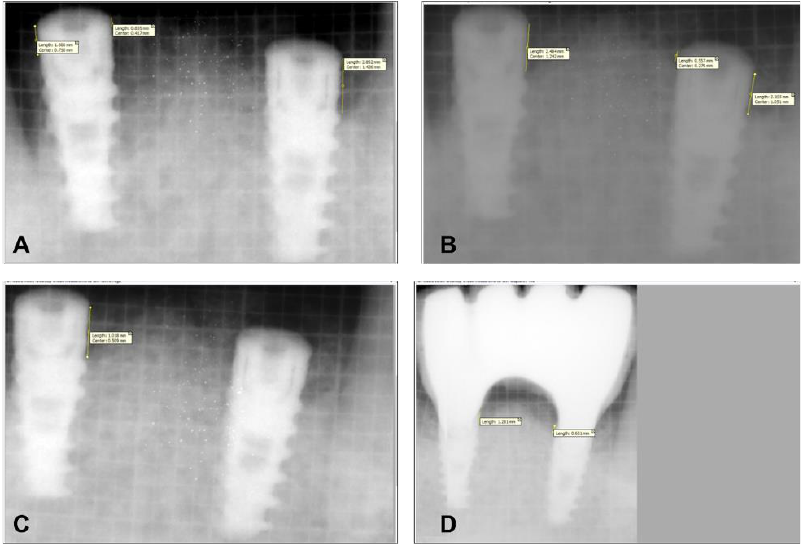
Figure 2. ( A ) Radiovisiograph of test site baseline; ( B ) radiovisiograph of test site at 3 months; ( C ) radiovisiograph of test site at 6 months; ( D ) radiovisiograph of test site at 9 months.